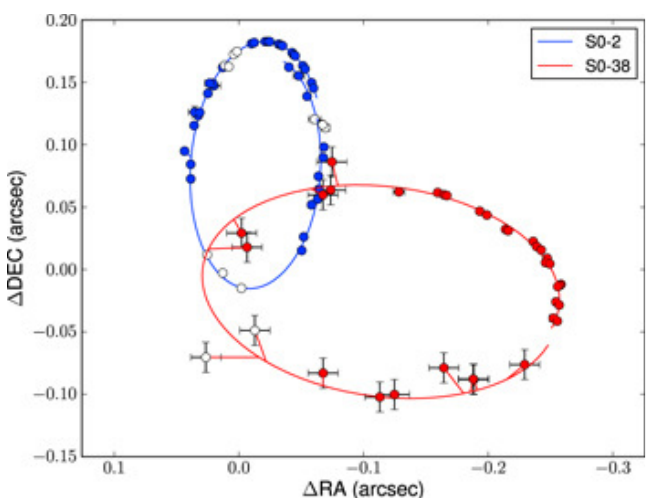
Figure 14. Positions on the plane of the sky and best-fit orbits of objects S0-2 (blue) and for S0-38 (red) for the period from 1995 to 2014. From